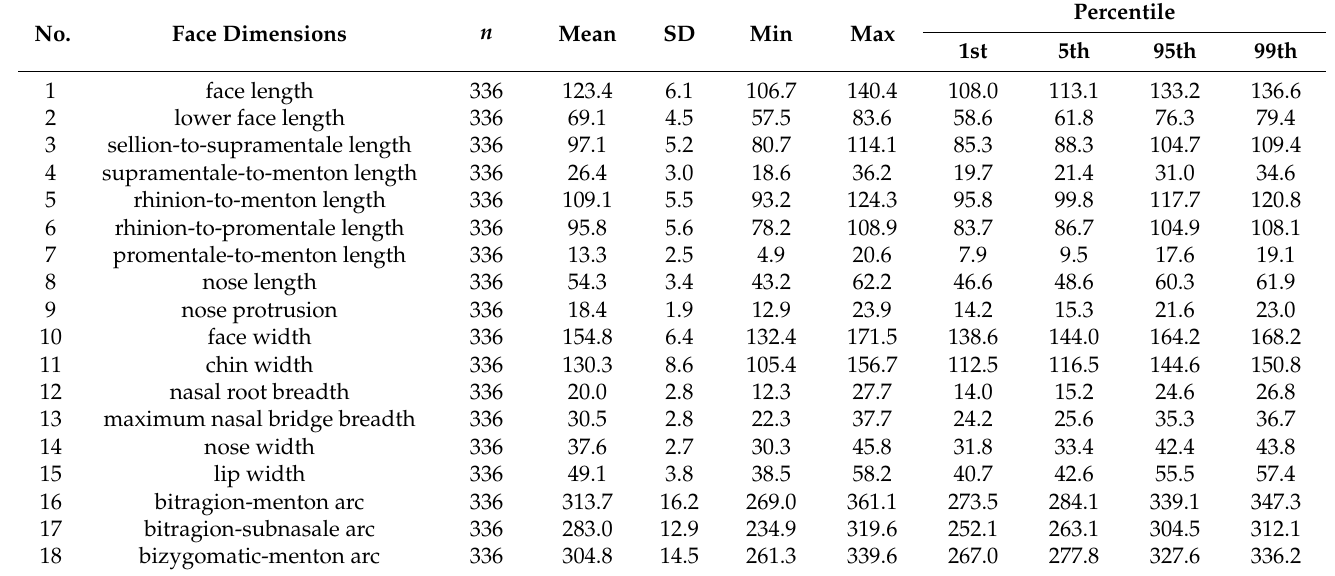
Table 1. Descriptive statistics of face dimensions derived by Lee et al. [5] (unit: mm).